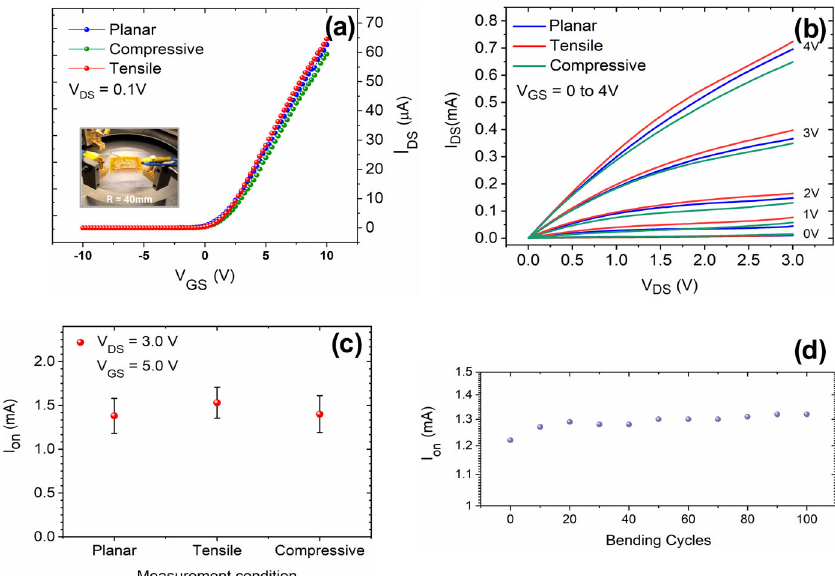
Fig. 4 Electro-mechanical characterization of printed Si NRFETs. a Measured transfer characteristic ( I DS vs. V GS ) of Si-NRFET under planar, tensile, and compressive bending conditions. b Output characteristics of Si-NRFET at planar, and under bending conditions (Rc = 40 mm)). c Variation of the on-state current at V GS = 5 V at compressive and tensile bending cycles. d Variation of the drain current at planar condition during compressive and tensile bending cycles at V DS = 3 V, V GS = 5